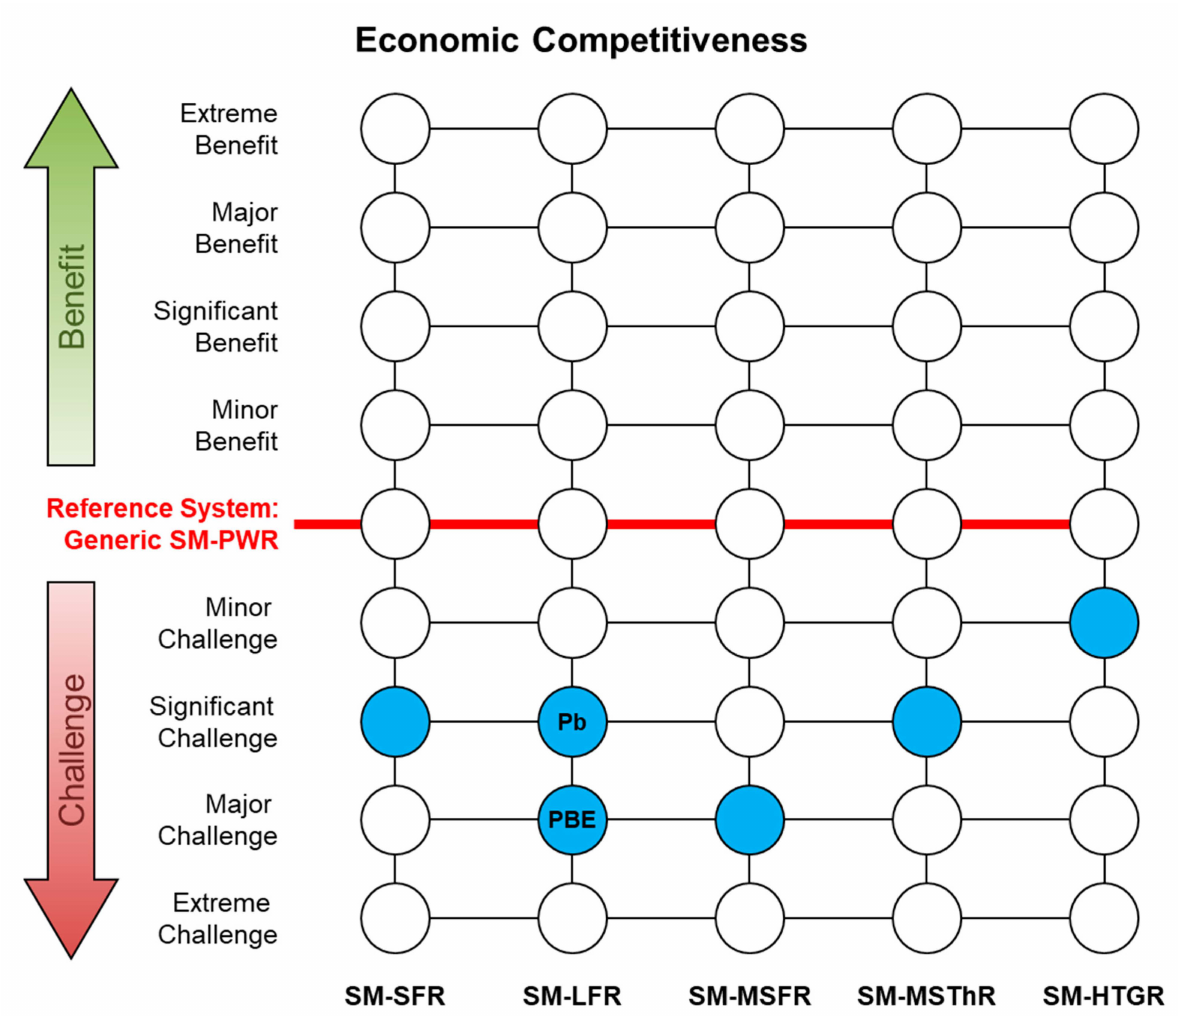
Figure 7. Economic Competitiveness from GFAs. Note that the SM-LFR has two ratings, referring to the use of either lead or lead-bismuth eutectic (PBE) as coolant.